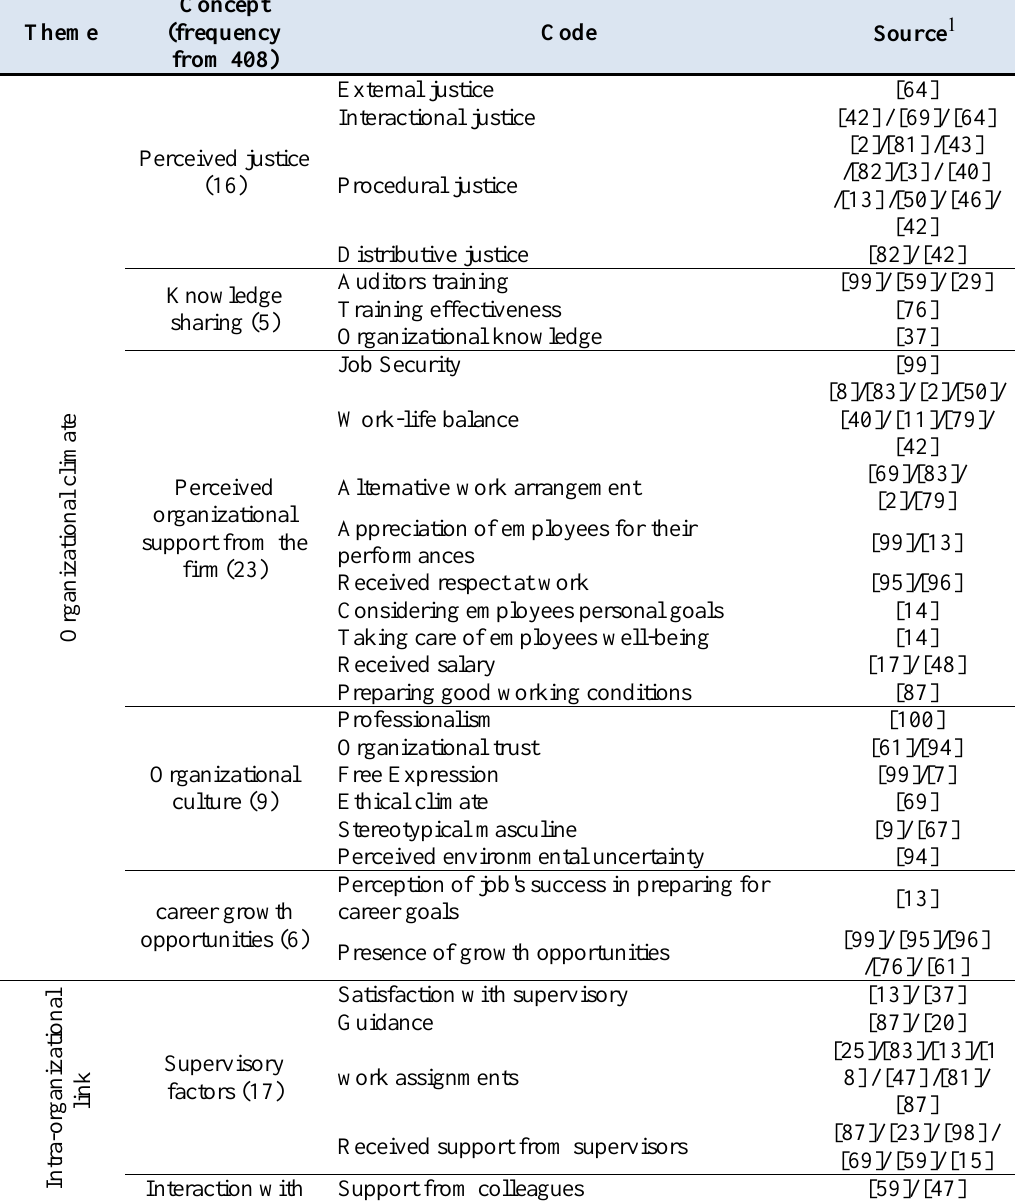
Table 3. Sources and frequency of Themes, Concepts and